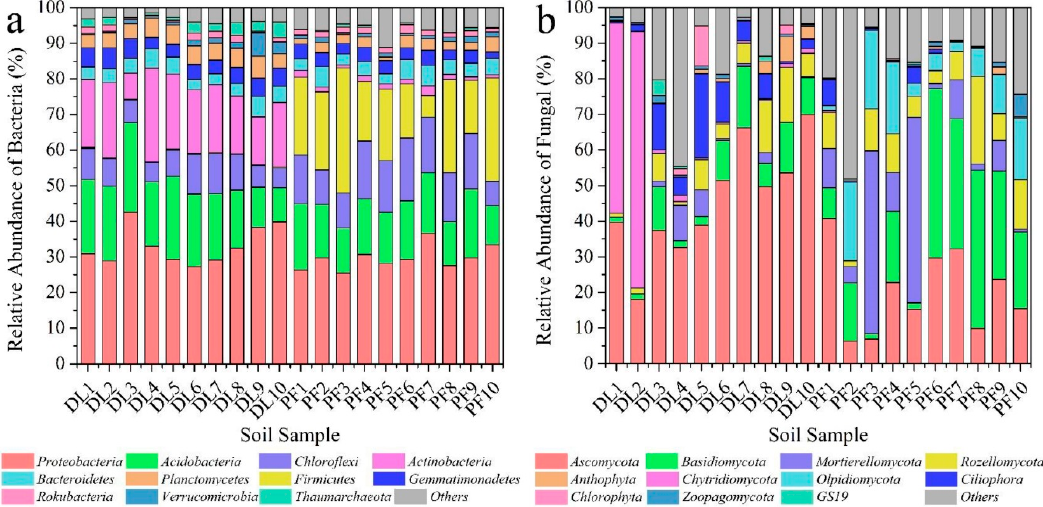
Figure 3. Abundance of soil ( a ) bacteria and ( b ) fungi communities for di ff erent land use types at the phylum level.